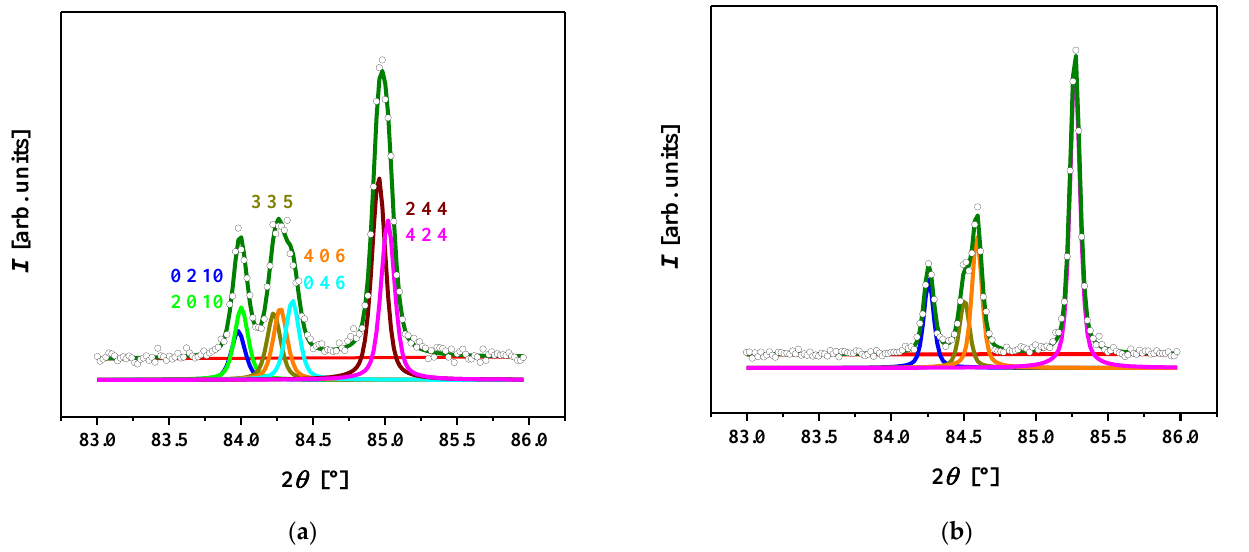
Figure 1. Experimental XRD patterns of the La 2 NiO 4+δ ( a ) and La 1.9 Ca 0.1 NiO 4+δ ( b ) samples illustrating the phase transition from an orthorhombic to a tetragonal structure with Ca doping. XRD data were obtained at the Anomalous Scattering station (SSRTC, Novosibirsk) at a wavelength of 0.15402 nm.